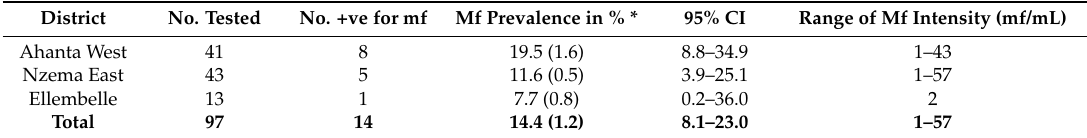
Table 6. Prevalence of microfilaria and mean intensity of infection among study participants by